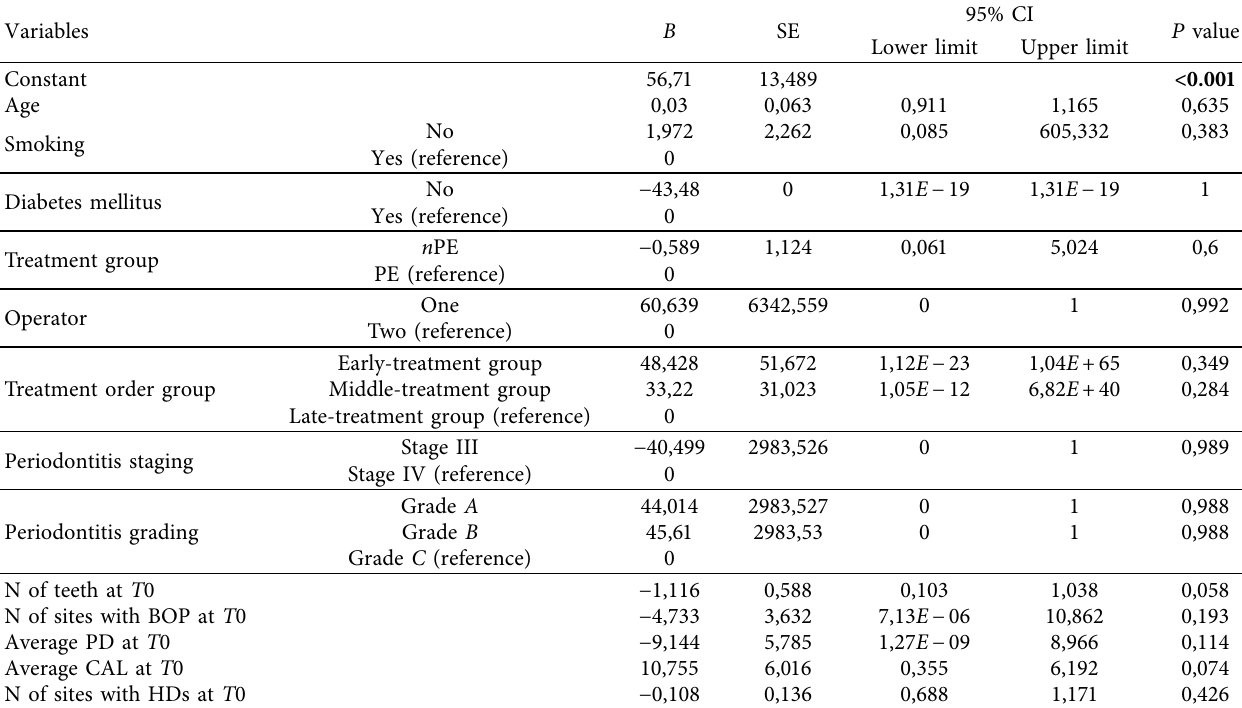
Table 4: Results of linear regression analysis at the patient level.